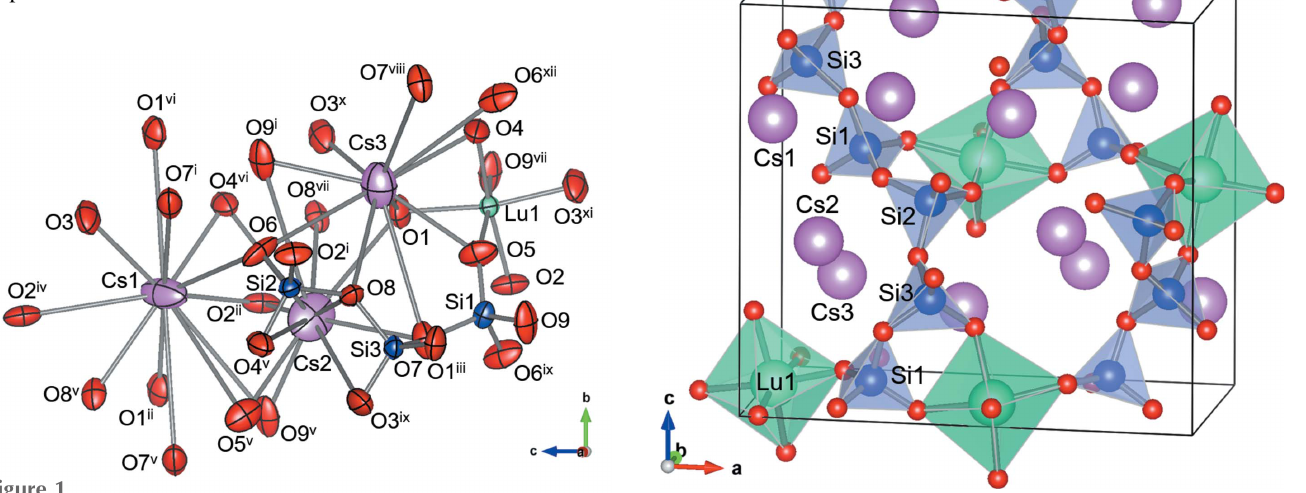
Figure 2 A polyhedral representation of Cs 3 LuSi 3 O 9 showing the Lu1-centered oxygen octahedra (green) and Si-centered oxygen tetrahedra (blue) linked together to form a 3-D framework with Cs ions (purple) contained in the framework voids.